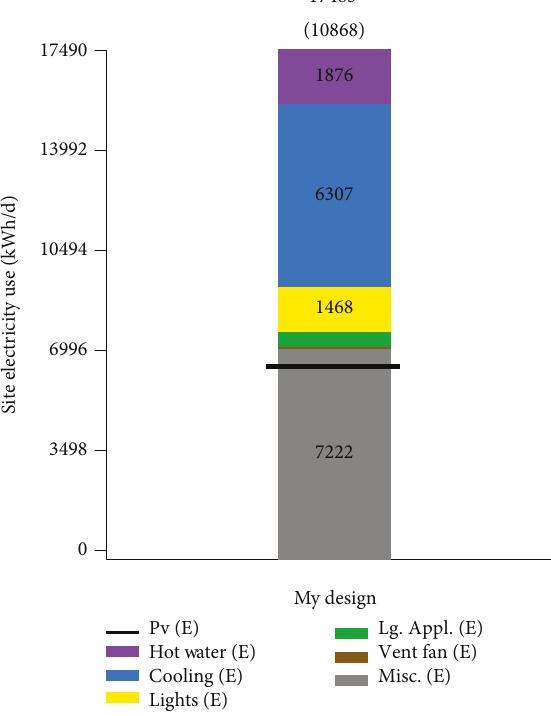
Figure 3: House annual energy consumption from BEopt